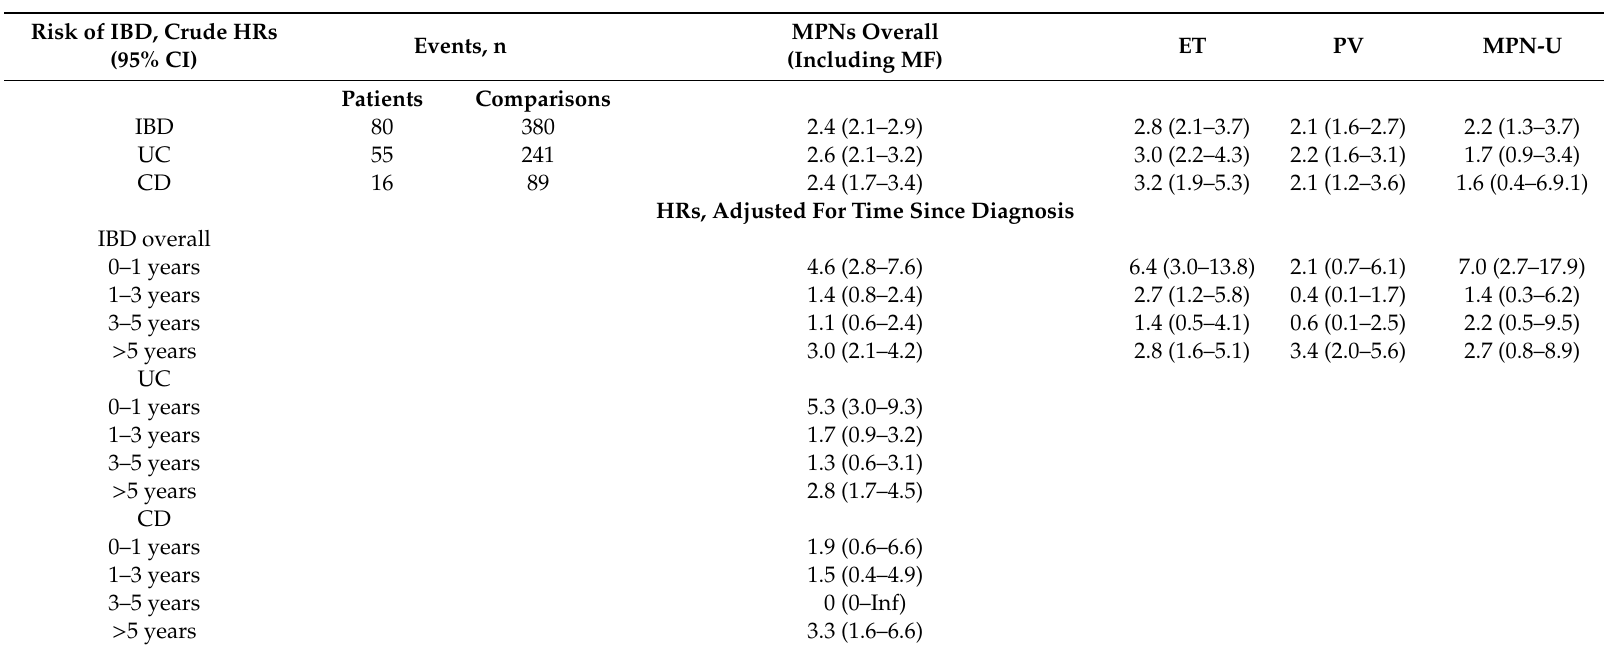
Table 3. Hazard ratios for IBD among patients with MPN compared to sex- and age-matched comparisons from the general population. Risk of IBD, Crude